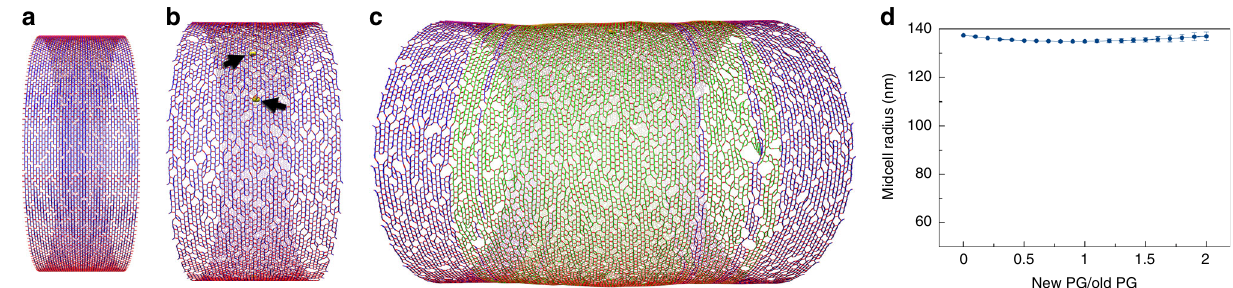
Fig. 1 Cell wall synthesis at the midcell. Existing glycan strands are visualized in blue, new strands in green, and peptide crosslinks in red. The same color scheme is used for all other fi gures containing simulation snapshots. a A snapshot of the starting peptidoglycan (PG) cylinder in a relaxed state. The cylinder was composed of 40 hoops of glycan strands with 400 tetrasaccharides per hoop and had a relaxed radius of 127.5 nm. b A snapshot of the pressurized PG cylinder that was expanded to a radius of 137.5 nm under a turgor pressure of 3 atm. The arrows indicate PG synthesis enzyme complexes placed randomly at the midcell. c A snapshot of the PG cylinder after elongation to three times its original length by insertion of new PG. d The pro fi le of the midcell radius with respect to the amount of new PG inserted, showing that PG synthesis at the midcell alone only elongated the cylinder without constricting it. The average of four simulations is shown. Error bars indicate